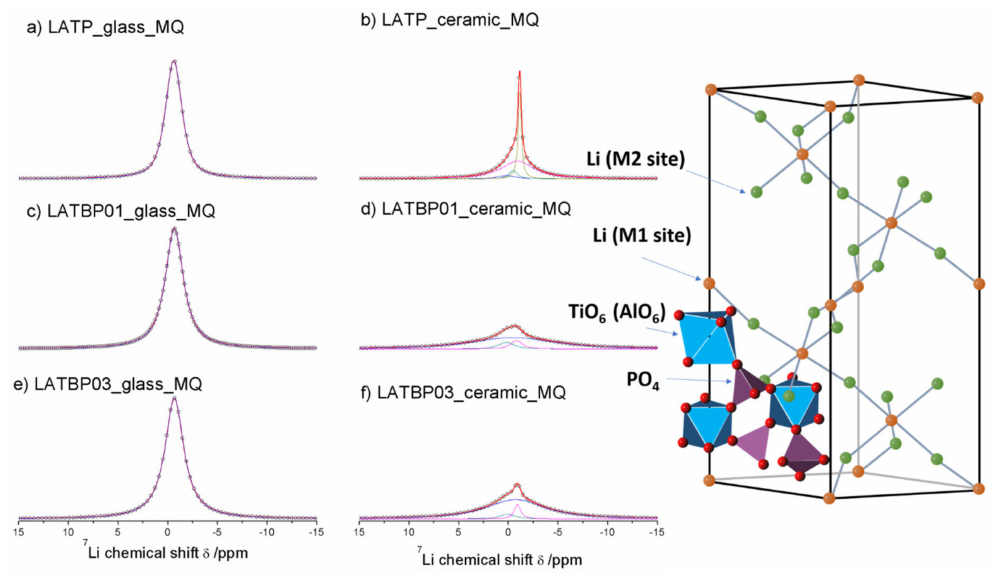
Figure 8. 1D 7 Li MAS NMR spectra of the LAT(B)P_MQ series. ( a ) LATP_glass_MQ ( b ) LATP_ceramic_MQ ( c )